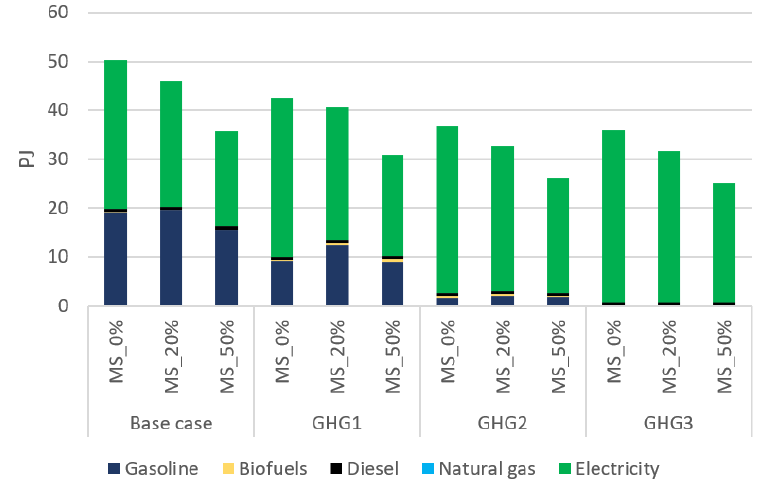
Figure 11. Final energy consumption for the transportation sector in 2050 under different scenarios and transport modal